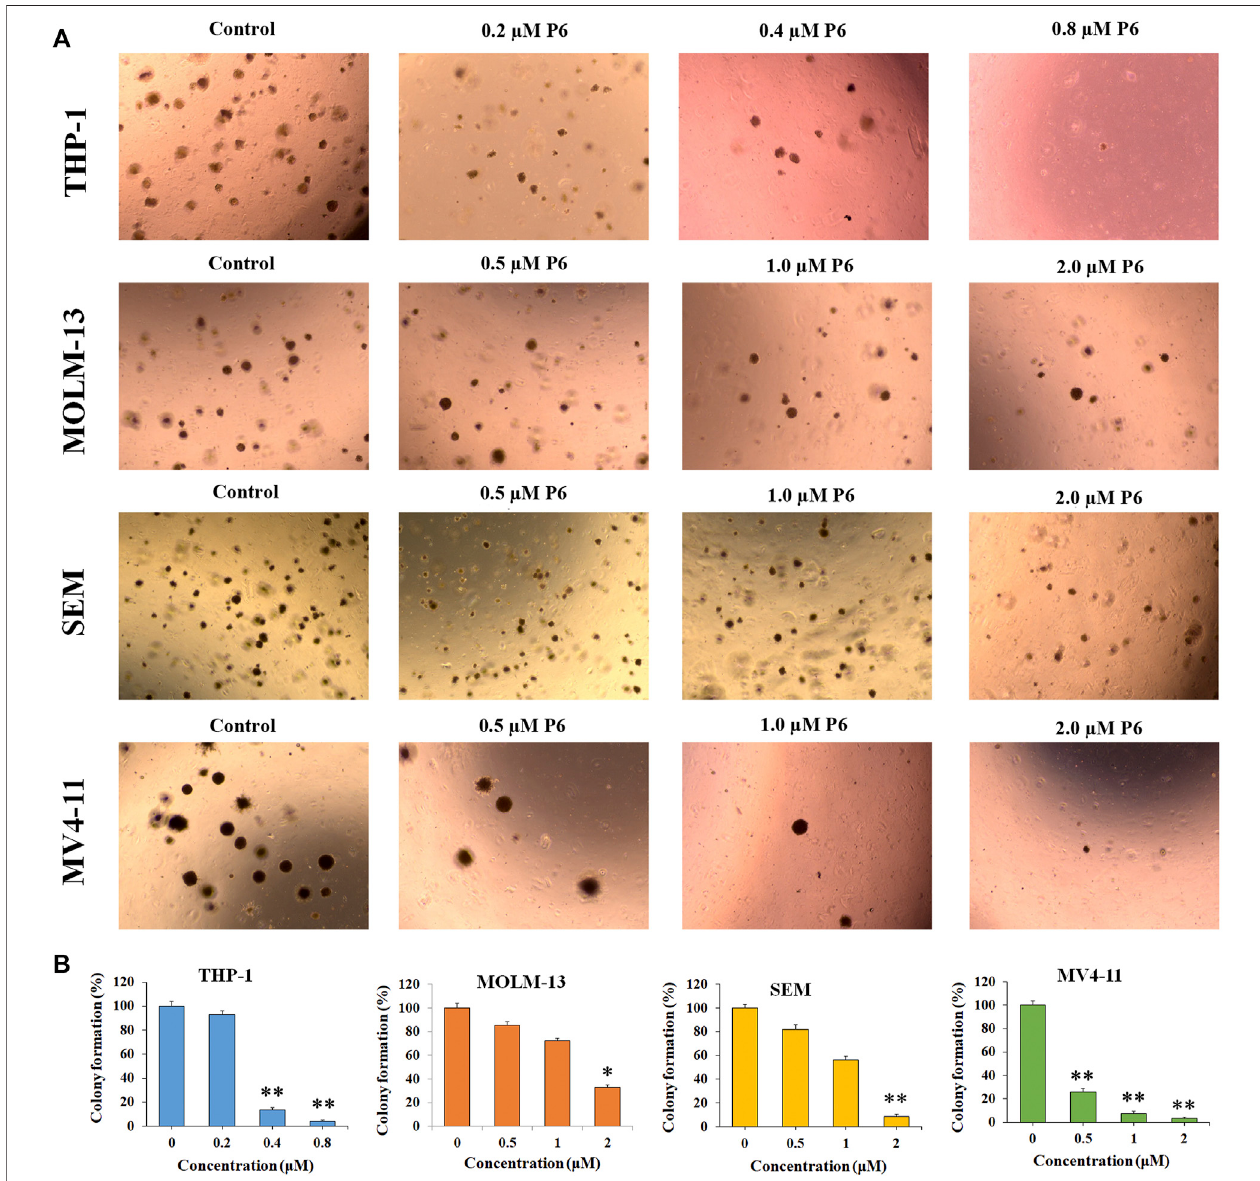
FIGURE4| P6suppressesthecolonyformationinTHP-1,MOLM-13, SEMandMV4-11cells. (A) Cellsmorphologyobservedunderlightmicroscopyaftertreated with P6 at the concentrations of 0.2 – 2 mM for 12 days. (B) Graph illustration of the colony number (* p < 0.05, ** p < 0.01).